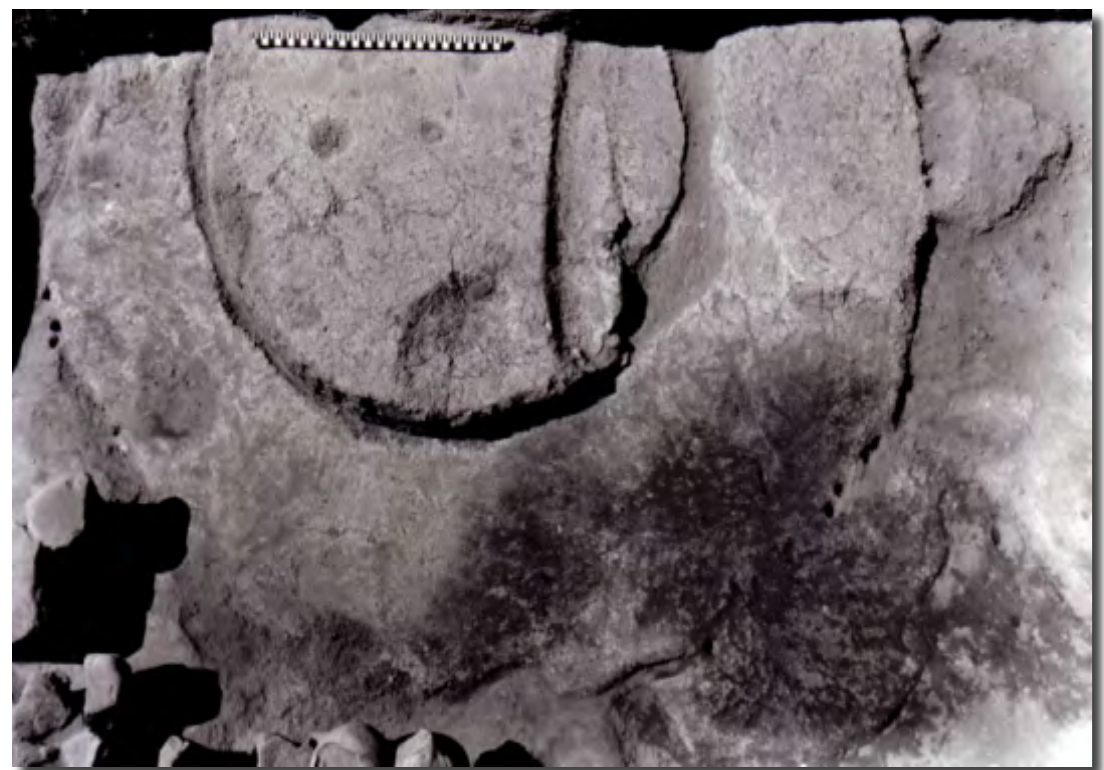
Figure 16. A veranda type circular pole and daub structure consisting of an inner wall, an outer wall, gravel floors with modelled hollows in the inner floor, and a doorway with a low step in the outer wall, in Excavation Ts 4, K2. (Meyer 1998:83, Figure 3.21, 3.27). Outside